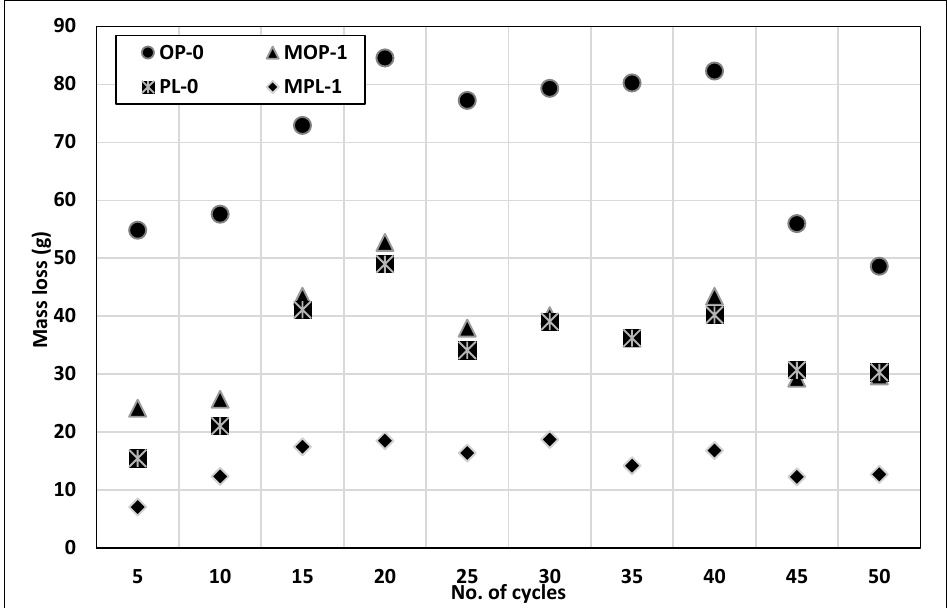
Figure 10. Results of scaling resistance.